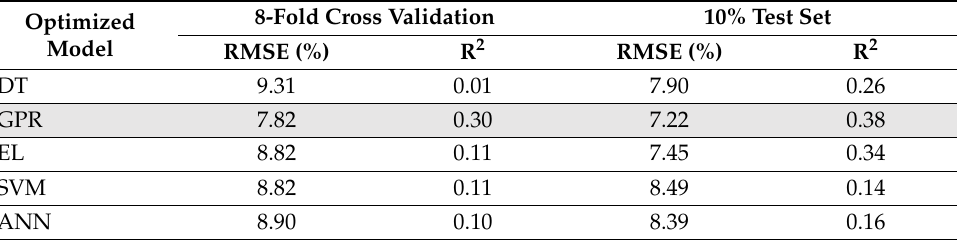
Table 5. Prediction performance of the five optimized ML models trained on the original non- augmented dataset for soil moisture retrieval. Performance metrics are measured over an 8-Fold cross validation scheme and for 10% holdout test set. The entries of the best performing model are highlighted in grey